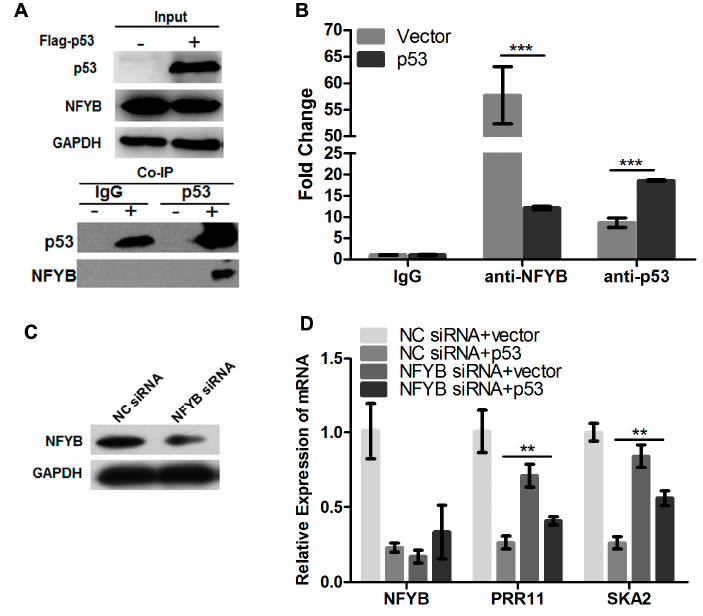
Figure 4. p53 represses PRR11-SKA2 transcription by decreasing the recruitment of NF-Y on the PRR11-SAK2 promoter. ( A ) p53 interacts with NF-Y. H1299 cells were transiently transfected with